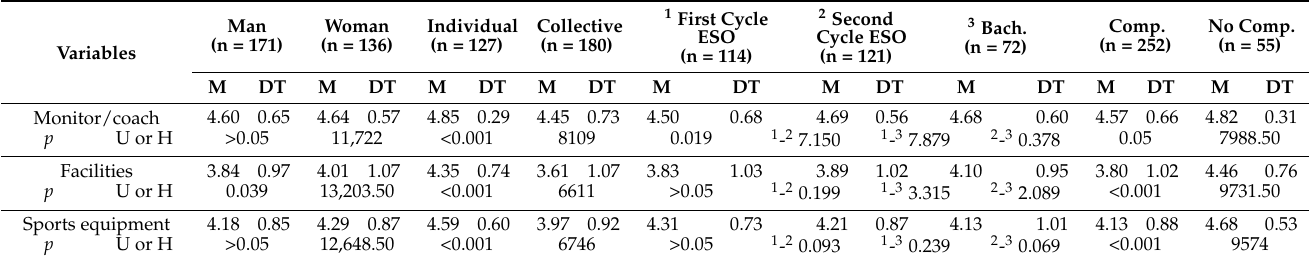
Table 2. Relationship between the factors of the EPOD2 questionnaire and socio-sportive